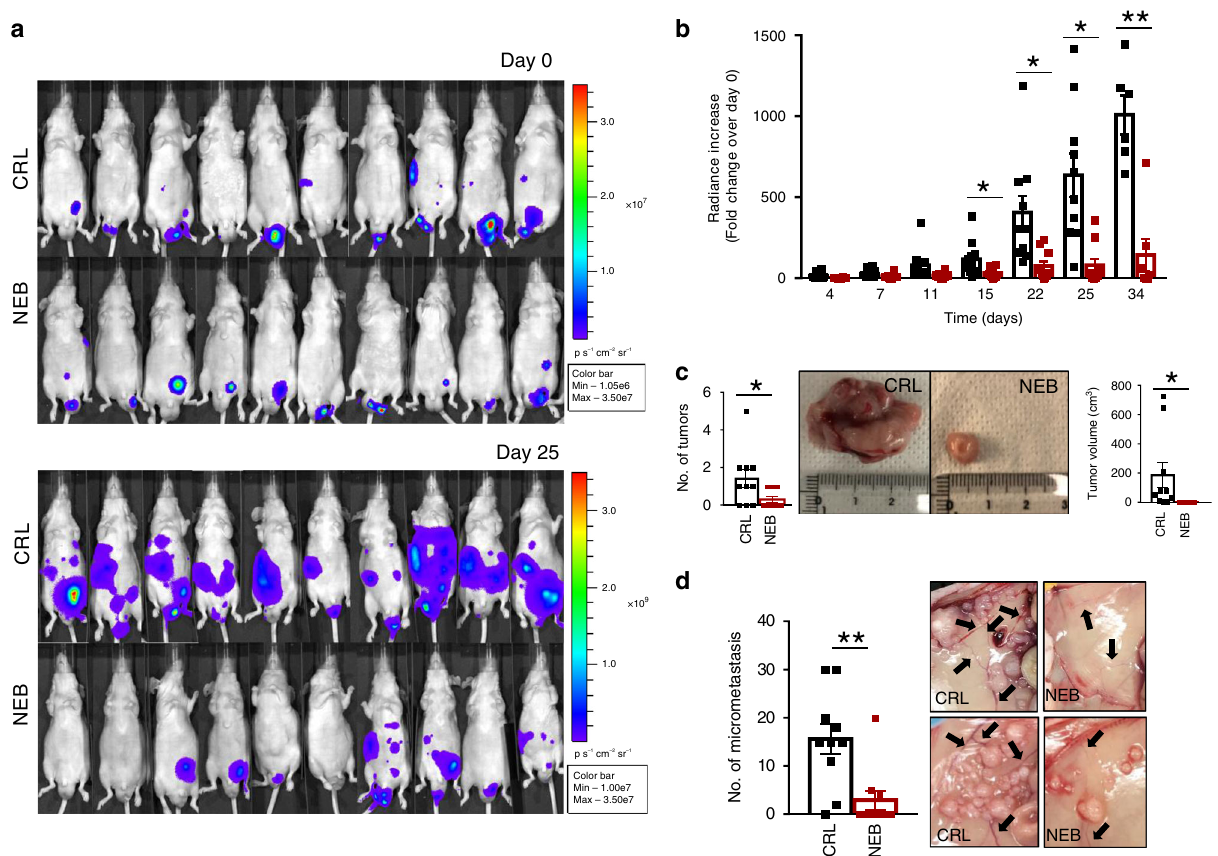
Fig. 7 Nebivolol halts cancer growth in orthotopic colon mice. HCT116-Luc cells were injected into the cecum of nude mice. Mice were treated with saline (CRL; black trace and bars; n = 10) or 10 mg kg − 1 nebivolol (NEB; red trace and bars; n = 10) and sacri fi ced after 35 days of treatment. Bars indicate the mean ± SEM. * p < 0.05 and ** p < 0.01 when compared to CRL by two-sided Student ’ s t test. a Representative images of the bioluminescence of HCT116-Luc tumors in mice at day 0 and after 25 days of initiation of the indicated treatment. Light emission of the cells was measured after injection of 150 mg kg − 1 of D -Luciferin. b The histograms show the fold change of the radiance increase after 4, 7, 11, 15 (* p = 0.03), 22 (* p = 0.04), 25 (* p = 0.02) and 34 (** p = 0.0002) days of treatment. c Left panel shows the histograms for the quanti fi cation of the number of tumors found in the mice (* p = 0.04). Right panel shows representative images of the size and aspect of the tumors and the histograms for the quanti fi cation of tumor volume (* p = 0.04). d Left panel shows the histograms for the quanti fi cation of the micrometastasis found in the mice. Right panel shows representative images of the micrometastasis. Black arrows point to the vessels around the tumors (** p = 0.003). Source data are provided as a Source Data fi